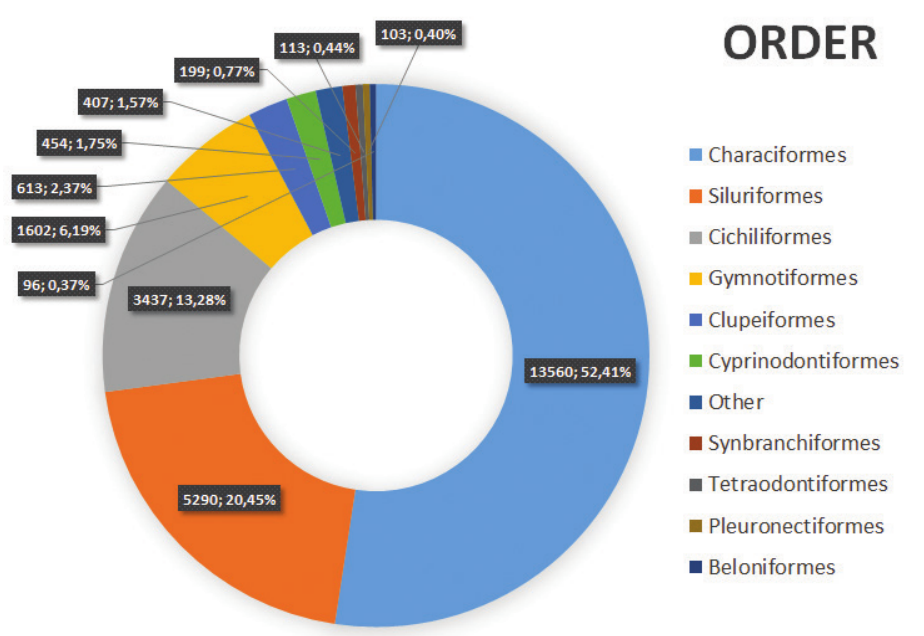
Figure 1. Distribution of species in the MPEG. Number of species and frequencies are represented for each